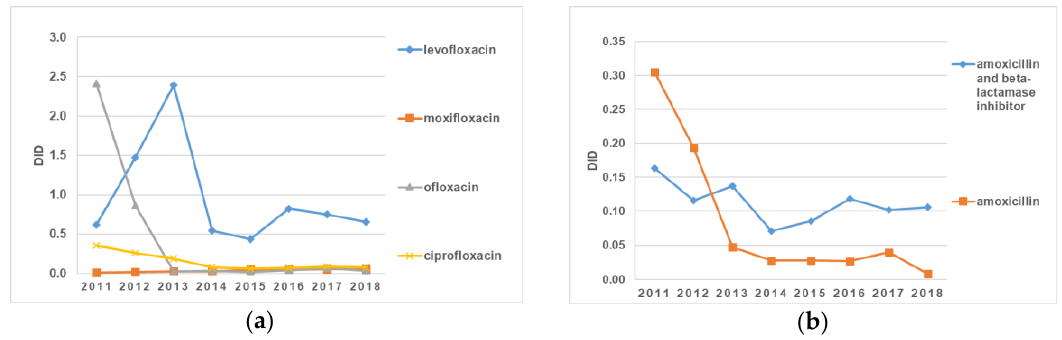
Figure 4. ( a ) The consumption of ofloxacin, ciprofloxacin, levofloxacin, and moxifloxacin in the Kazakh population between 2011 and 2018; ( b ) a comparative analysis between the consumption of amoxicillin and the consumption of amoxicillin with a beta-lactamase inhibitor.